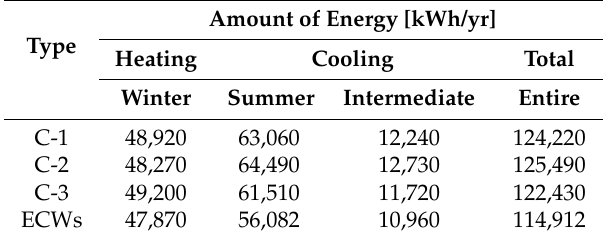
Table 5. Annual energy consumption by season.